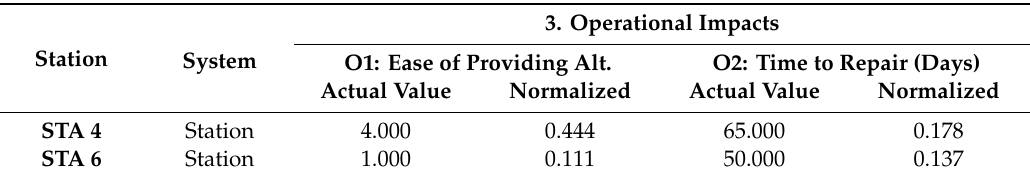
Table 7. Operational Impacts